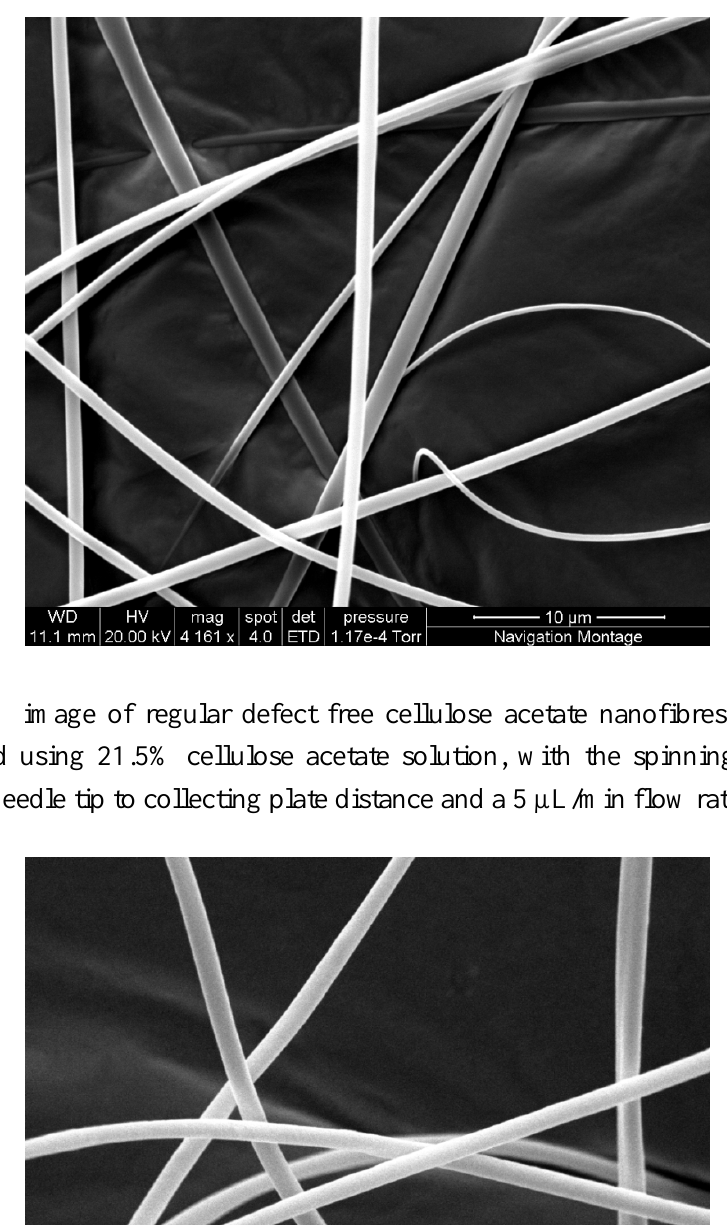
Figure 1. SEM image showing regular defect free fibres produced using 20% cellulose acetate solution with spinning parameters of 15 kV at a distance of 17.5 cm and a flow rate of 15 µL/min.